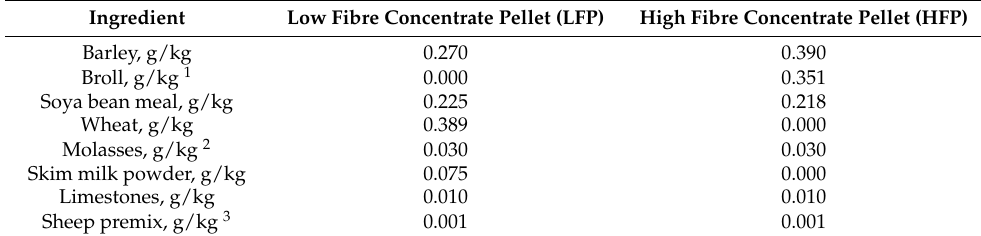
Table 1. Pellet composition in fresh matter basis (Adapted from Herath et al.